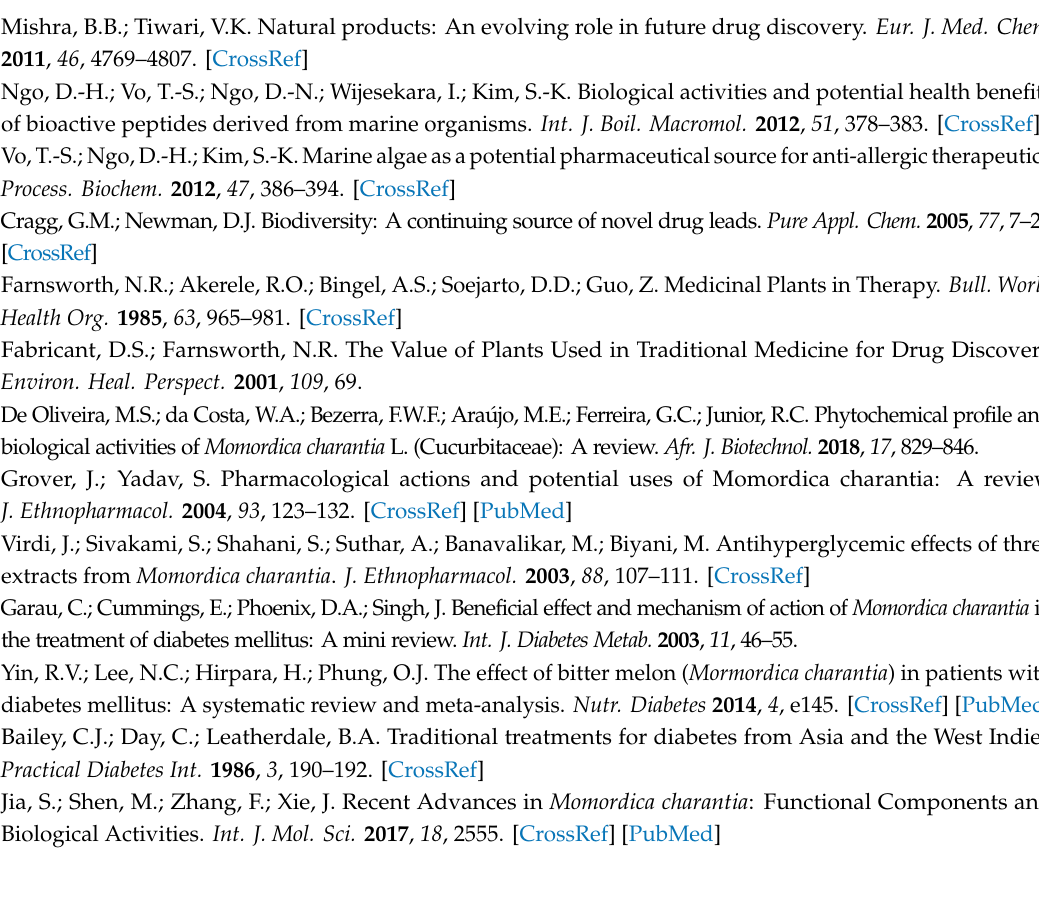
Figure S1: DPPH and ABTS + scavenging e ff ect of DMSO 10%. Author